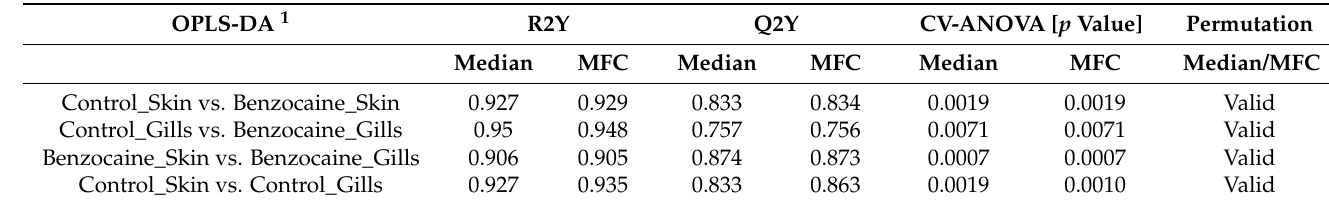
Table 2. The quality parameters of OPLS-DA models associated with normalization-by-median and median fold change (MFC)